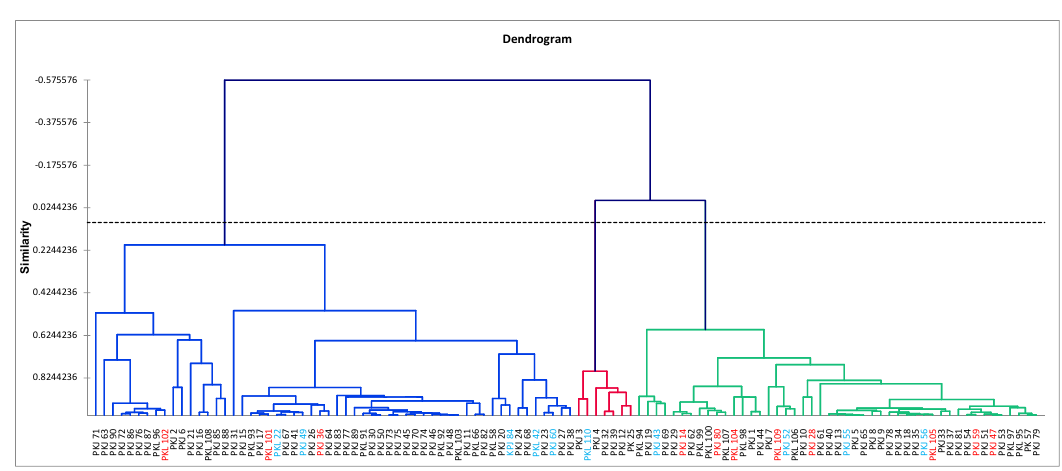
Figure 1. Clustering dendrogram showing cluster patterns of 110 Pinus koraiensis clones grown at the Naozhi orchard using the unweighted pair-group average method with Pearson correlation coefficient of similarity indices on 28 growth, wood, cone, seed, and nut traits. Genotypes in red and blue represent 10% of clones having exhibited high clonal value in volume and seed weight, respectively.